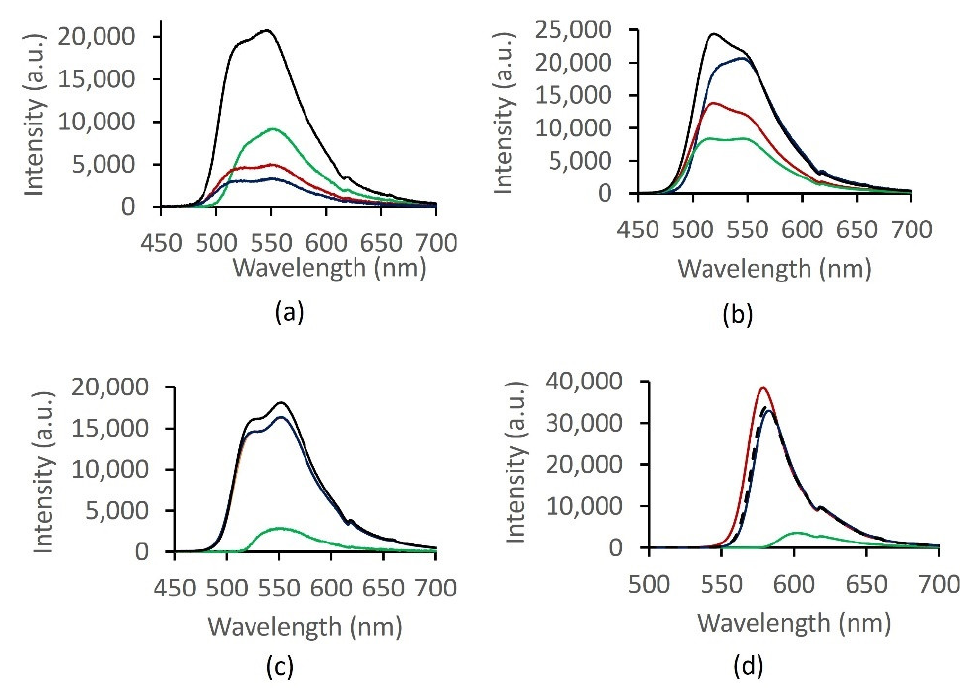
Figure 7. Emission intensities with Ca 2+ , K + and Mg 2+ ; ( a ) 1 , ( b ) Fl, ( c ) Fl-OH and ( d ) Rh. Color: black (Ca 2+ ), red (K + ), blue (Mg 2+ ) and green (fluorophore).